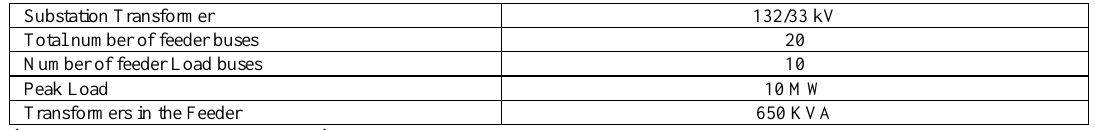
Table 1. Details of the NMRC distribution feeder.